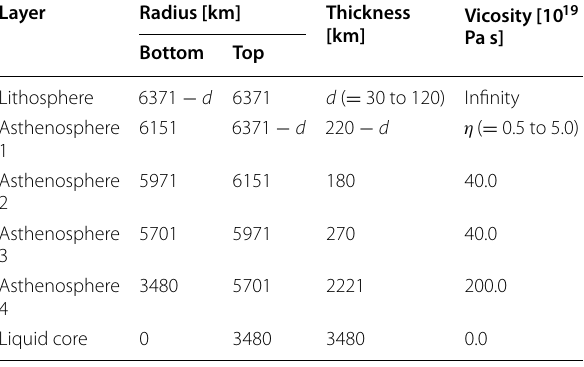
Vicosity [10 19 [km]